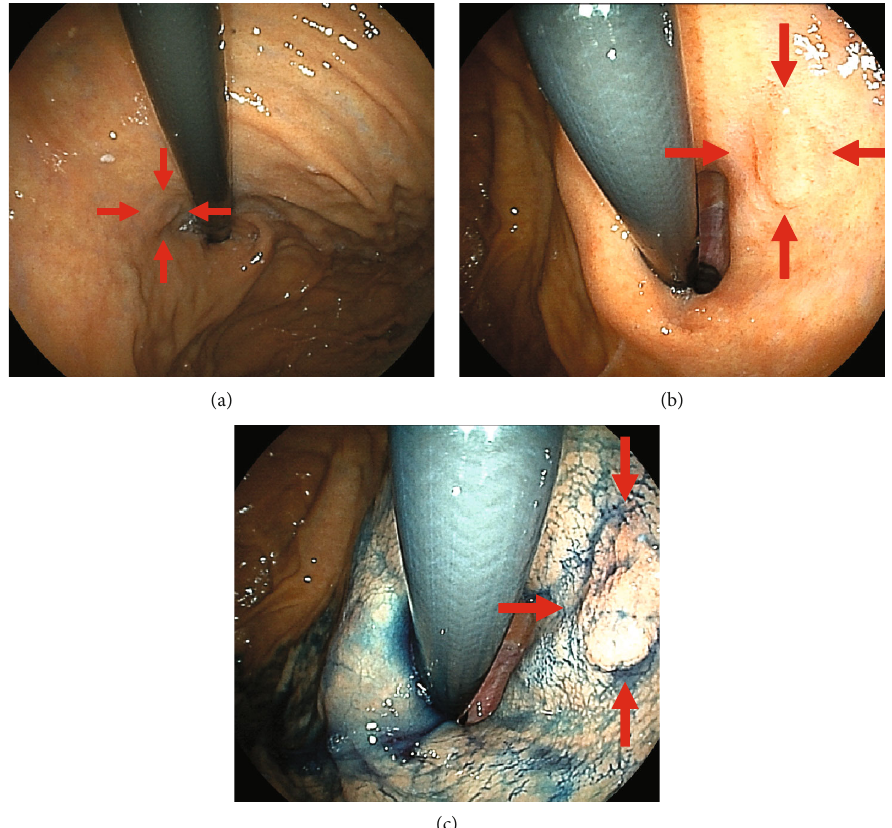
Figure 1: An example of a false-negative EGC. This patient had undergone EGD for an annual medical checkup after Helicobacter pylori eradication. (a) Endoscopy 8 months before detection. The cardia was observed in the retro fl ex view, but the scope was not close to the lesion located in the cardia at the lesser curvature, which can be recognized retrospectively (arrowhead). (b) Endoscopy at the time of detection. A slightly elevated lesion is shown (arrowhead). (c) It is clearly visible by indigo carmine chromoendoscopy. The biopsy specimen reveals well-di ff erentiated adenocarcinoma. EGC: early gastric cancer; EGD: esophagogastroduodenoscopy.